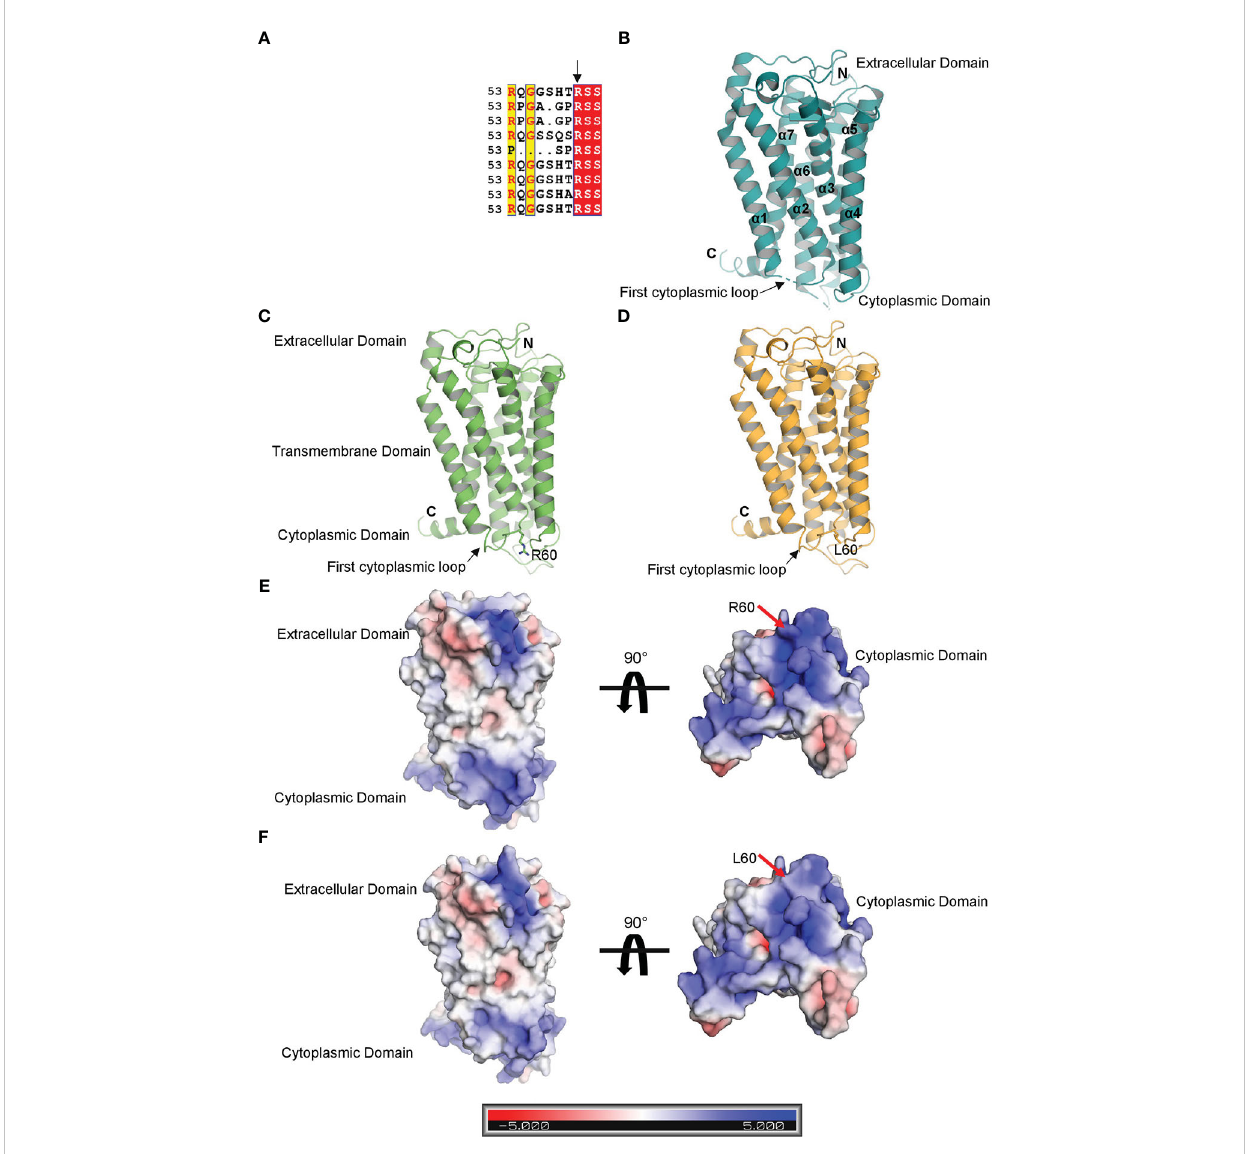
FIGURE 7 Structural analysis of TBXA2R and TBXA2R R60L. (A) Multiple sequence alignment of TBXA2R mammalian orthologs. (B) Cartoon representation of the crystal structure of human TBXA2R(PDB: 6IIU). Electron density de fi cient loops are shown with dotted lines. (C) Cartoon representation of 3-D Structural model of human TBXA2R depicted in smudge. R60 residue is depicted in stick. (D) Homology model of TBXA2R R60L is depicted in bright orange. L60 residue is shown in stick.Electrostatic surface potential of Wild type TBXA2R (E) and TBXA2R R60L (F) are coloured according to the bar underneath.The scale ranges from − 5 kT/e (red) to +5 kT/e